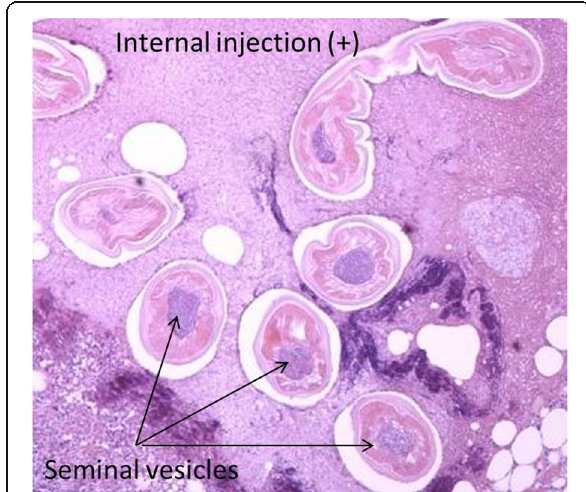
Fig. 3 Paraffin section of Dirofilaria species in a dorsal subcutaneous lesion